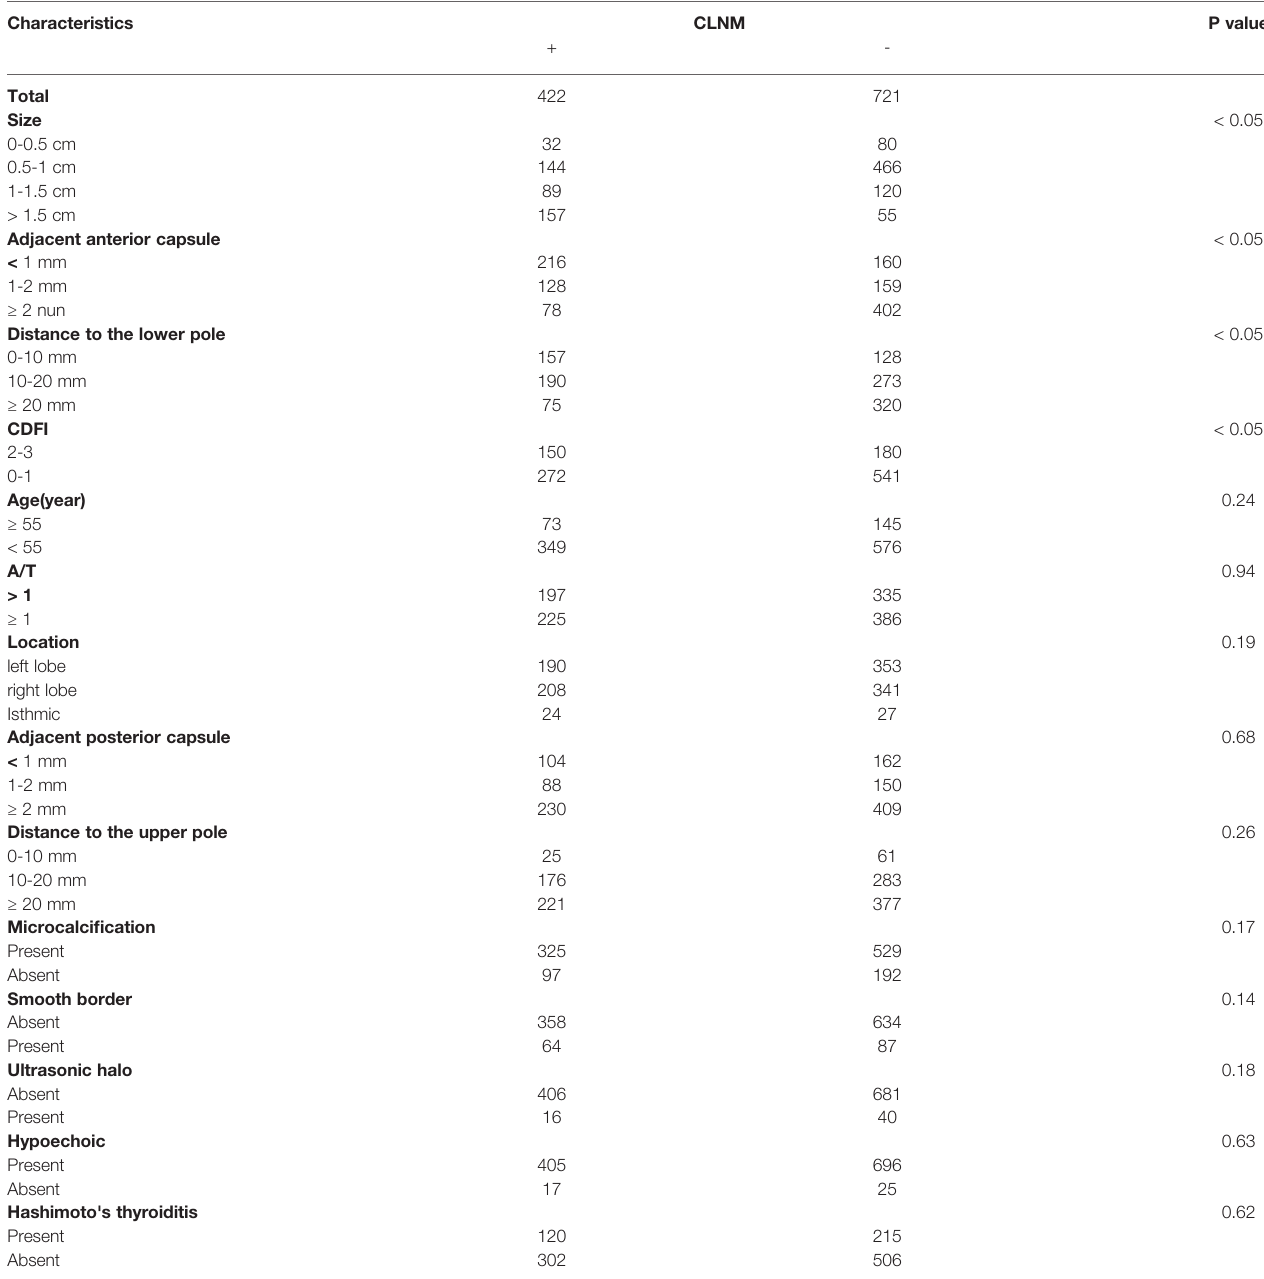
TABLE 2 | Clinical and US imaging characteristics of female patients.